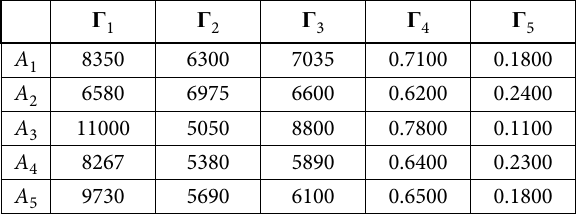
Table 1. The evaluation matrix